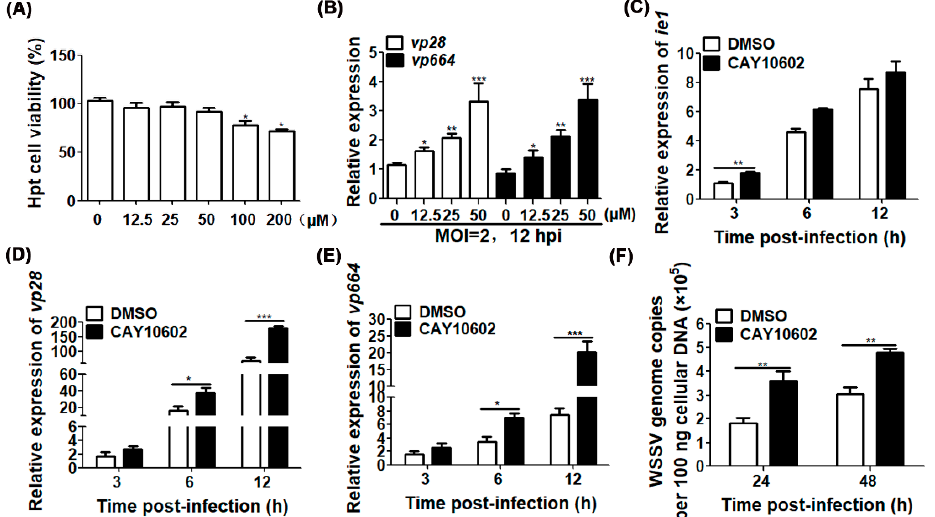
Figure 3. Enhancement of Cq SIRT1 deacetylase activity promoted WSSV replication. ( A ) Cytotoxicity test of SIRT1 activator CAY10602 in Hpt cells. Cell viability was evaluated in Hpt cells pre-treated with the indicated concentration of CAY10602 using the MTT assay. ( B ) The relative expressions of vp28 and vp664 in Hpt cells treated with CAY10602 in a dose-dependent manner. The relative expressions of both vp28 and vp664 were determined in Hpt cells pre-treated with the indicated concentration of CAY10602 followed by WSSV infection (MOI = 2). DMSO was used as negative control. ( C–E ) The relative expressions of viral genes in Hpt cells treated with CAY10602 at different stages during WSSV infection. The relative expressions of ie1 , vp28 and vp664 genes were determined in Hpt cells treated with 50 μ M of CAY10602 followed by WSSV infection for the indicated time points. Treatment with DMSO served as negative control. ( F ) WSSV genome copies in Hpt cells treated with CAY10602. The viral genome copies were determined in Hpt cells treated with 50 μ M of CAY10602 followed by WSSV infection for 24 h and 48 h. DMSO served as control treatment. All experiments were performed in biological triplicates and means ± SD were shown (*, p < 0.05; **, p < 0.01, ***, p <